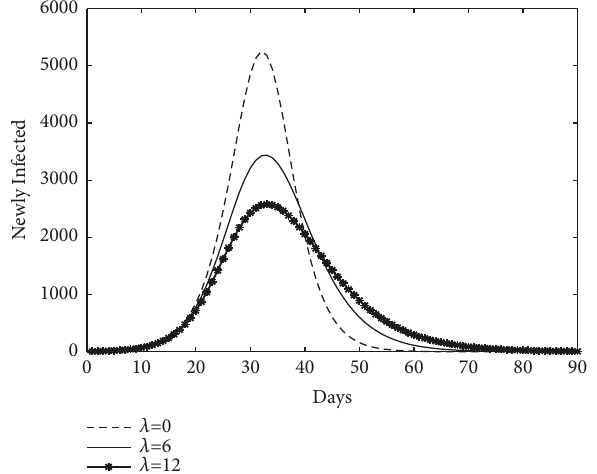
Figure 5: Effect of media coverage on the epidemics outbreak. Comparison of epidemics with 𝜆 = 0 (dash line), 𝜆 = 6 (solid line), and 𝜆 = 12 (dot solid line). In all these cases 𝛽 = 2, 𝑑 = 5, 𝑃 𝜏 = 1/5 (1 ≤ 𝜏 ≤ 5) , and the starting values are 𝑖(𝑡) = 0(−4 ≤ 𝜏 ≤ −1),𝑖(0) = 15,𝑆(−5) = 10 5